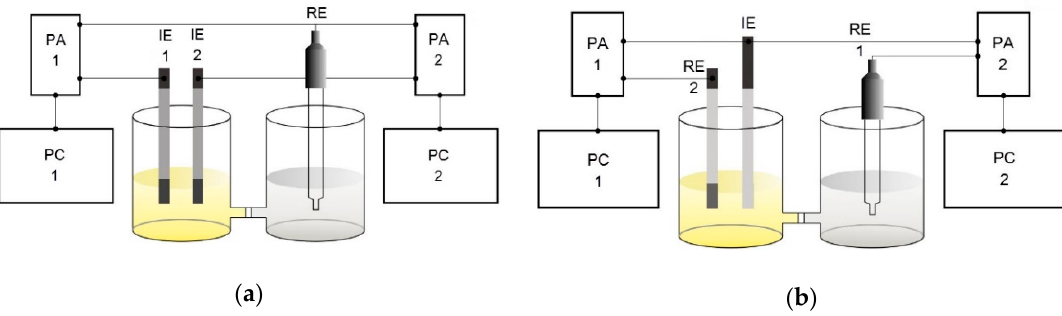
Figure 1. Schemes for measuring potential ( a ) of two indicator electrodes (IE 1 and IE 2) with respect to one reference electrode (RE); ( b ) one indicator electrode (IE) relatively to two reference electrodes (RE 1 and RE 2). PA 1 and PA 2: potentiometric analyzers; PC 1 and PC 2: personal computers; IE 1 and IE 2: modified AgSPEs; RE = RE 1: EVL – 1M3.1; RE 2: QRE mix .